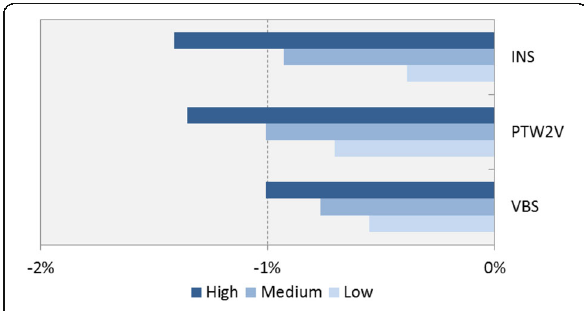
Fig. 3 The overall impacts (%) of systems on all road fatalities in the EU-28, full penetration. High/medium/low indicate the range of the estimate